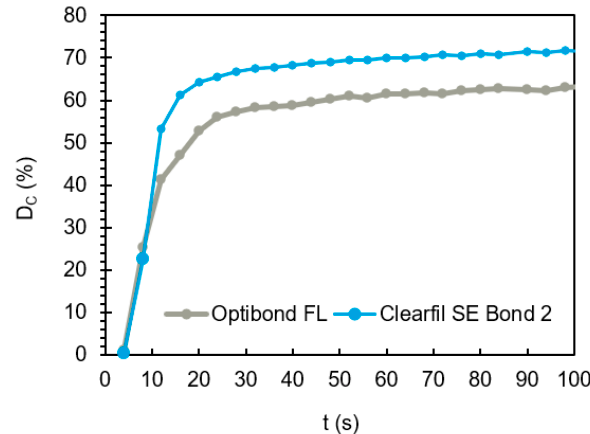
Figure 8. D C (%) versus time for mixed OBFL and CFSE bonding systems upon 20 s light exposure. At 10 s, the systems reach or surpass 50% of the maximum conversion level, showing that the polymerisation reaction is fast once light irradiation begins. The difference spectra obtained by subtracting the final from the initial spectra are given in Figure 9 for both mixed bonding systems. The methacrylate group peaks shift during the polymerisation process, particularly C=O, C=C, and C–O stretching vibrations leading to the observation of peaks and adjacent troughs. The level of change at each peak and trough is higher for CFSE compared with OBFL, consistent with a higher degree of conversion. Figure 9. Absorbance changes for OBFL and CFSE, after polymerisation. Note shift of C=O stretch peak around 1700 cm − 1 to 1730 cm − 1 ; loss of a 1635–1640 cm − 1 C=C stretch peak and shift of 1300– 1320 cm − 1 C–O stretch doublet to lower wavenumbers at 1268 and 1245 cm − 1 . 3.3. Agreement with the Information Supplied by the Manufacturers In order to summarise the findings of this study and compare them to the information supplied by the manufacturers, the table below was made. The amount of information not available by manufacturers is clearly visible, and fractions did not always conform what was found in this study, although the fractions verified with FTIR are susceptible to devi- ations (Table 6).